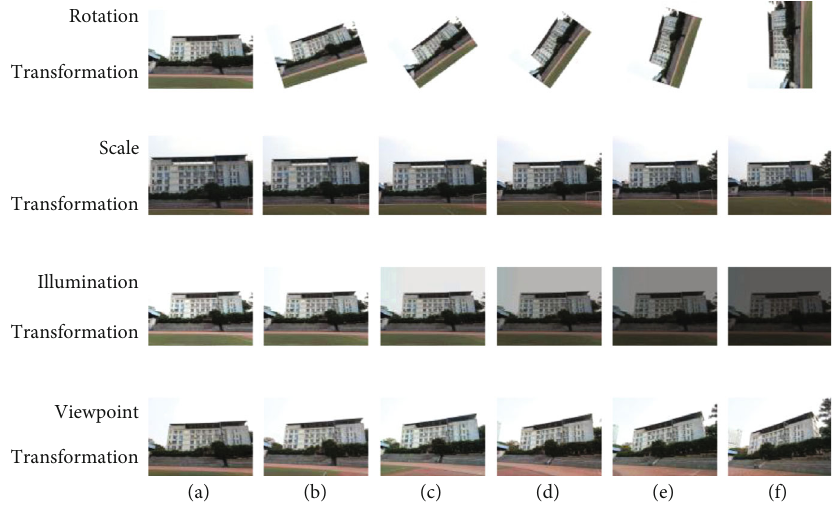
Figure 2: Outdoor scene test images for the experiment.